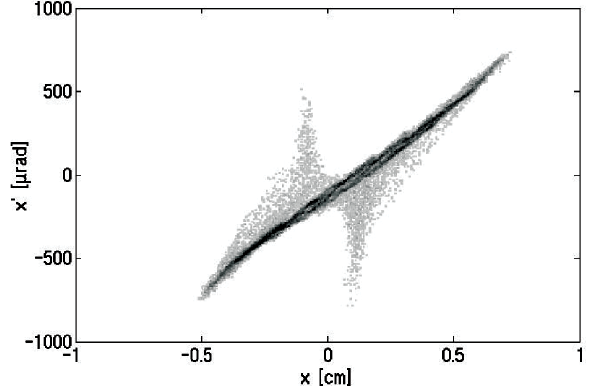
FIG. 12. Horizontal phase space output from CSRTRACK . The vertical axis is the horizontal slope, x 0 , measured in micro- radians. Both scales are identical to the scales of Fig. 11.